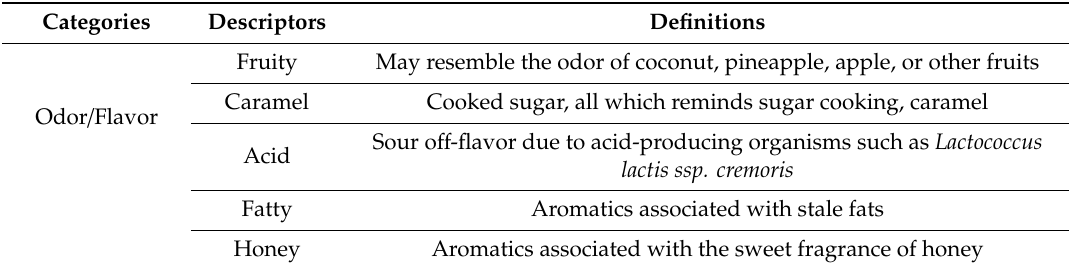
Table 2. Description and definition of the aroma of coconut